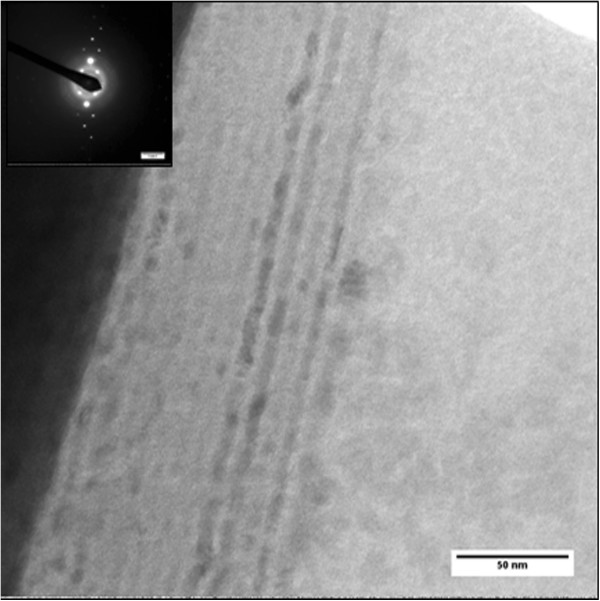
Bright-field image showing cross-sectional view of Al2O3/ZrO2(5:10 nm) multilayer film annealed at 1,273 K in HTXRD. Inset shows the SAED pattern.